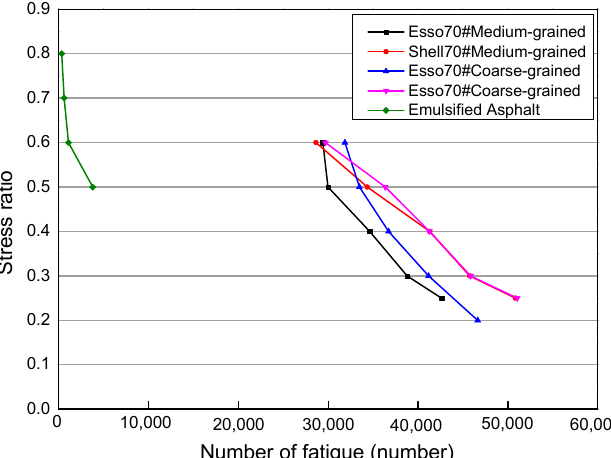
Figure 9. Comparison of Emulsified Asphalt Cold Recycled Mixtures and Hot Mix Asphalt Mixtures.